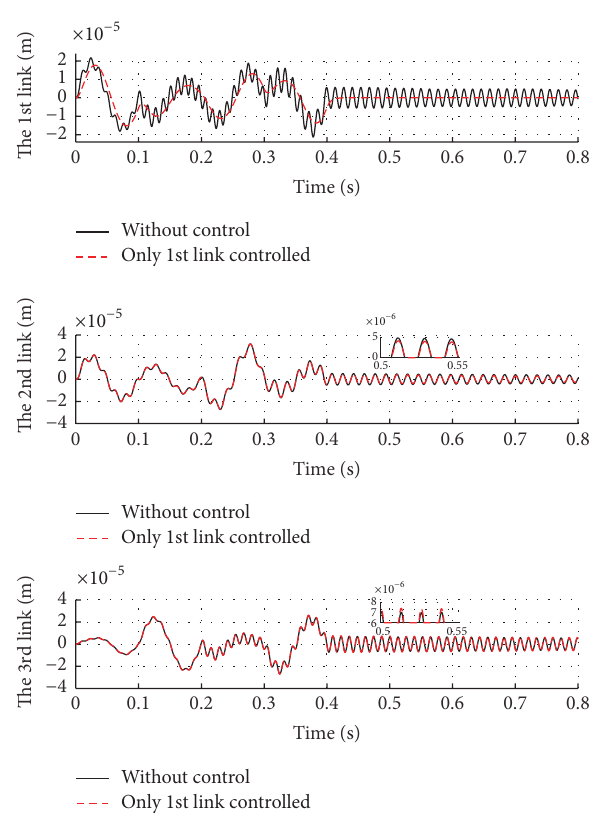
Figure 7: The vibration response of the three flexible links under the second